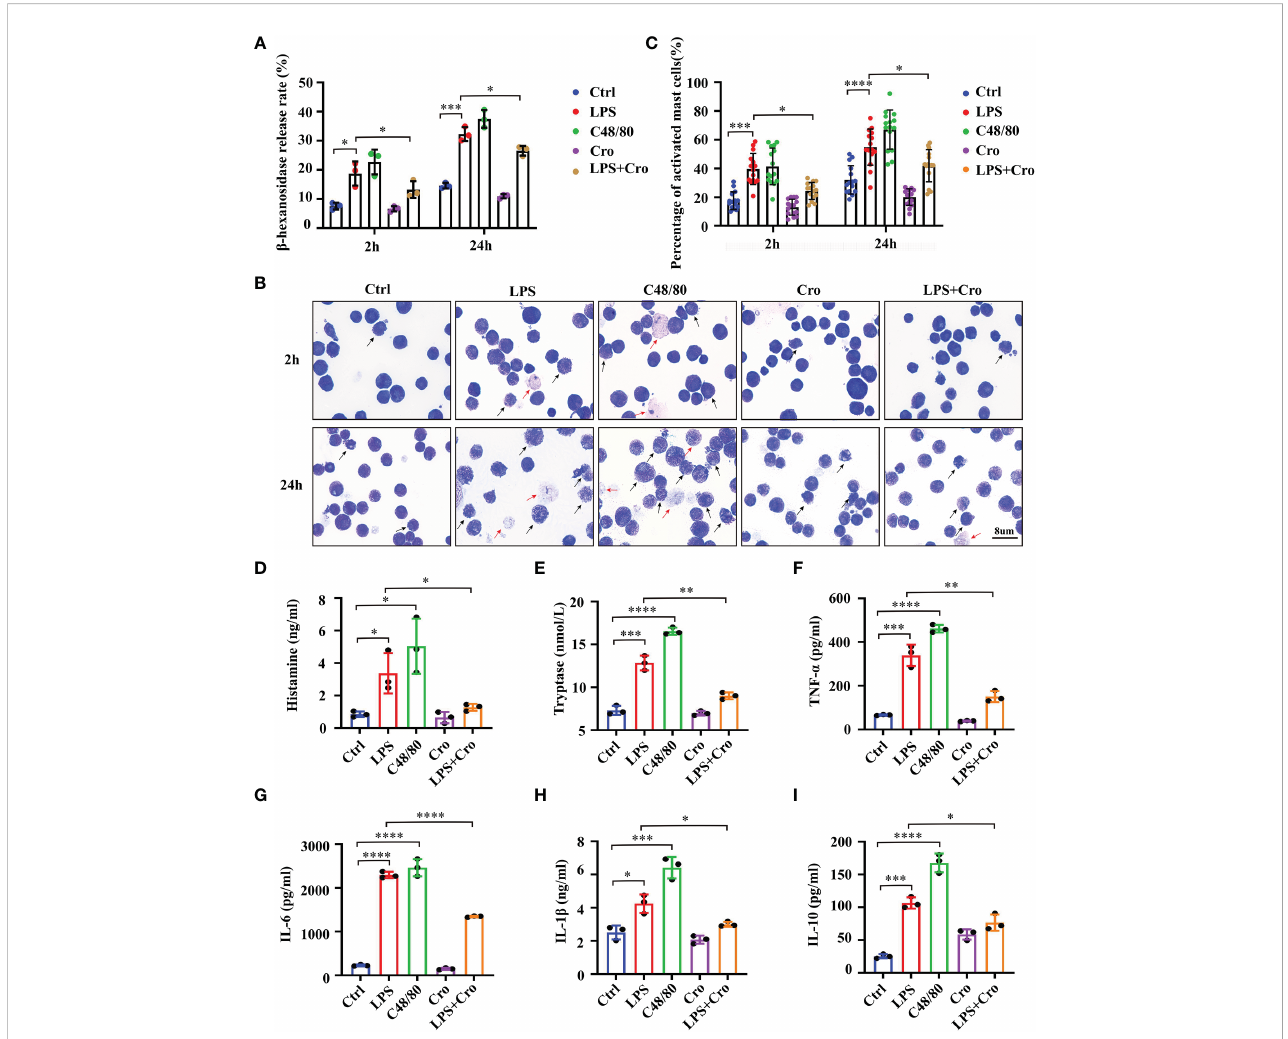
FIGURE 5 LPS successfully induced the degranulation of MCs, and cromolyn effectively stabilized LPS-induced MC activation in vitro . (A) Degranulation of P815 cells stimulated by LPS was analyzed by b -hexosaminidase release assay. C48/80 treatment was used as the positive control (n=3). (B) Morphological properties of MCs activation were investigated using the TB staining of the cell smears (Black arrow: activated MCs, red arrow ghost-like cell; 1000x; n=3). (C) Quanti fi cation of activated MCs in TB staining of the cell smears (n=3). ELISA was used to detect the levels of histamine (D) , tryptase (E) , TNF- a (F) , IL-6 (G) , IL-1 b (H) and IL-10 (I) in the medium supernatant of P815 cells (n=3). LPS, Lipopolysaccharide; C48/80, Compound 48/80; TB, Toluidine blue. (* p < 0.05, ** p < 0.01, *** p < 0.001, **** p <